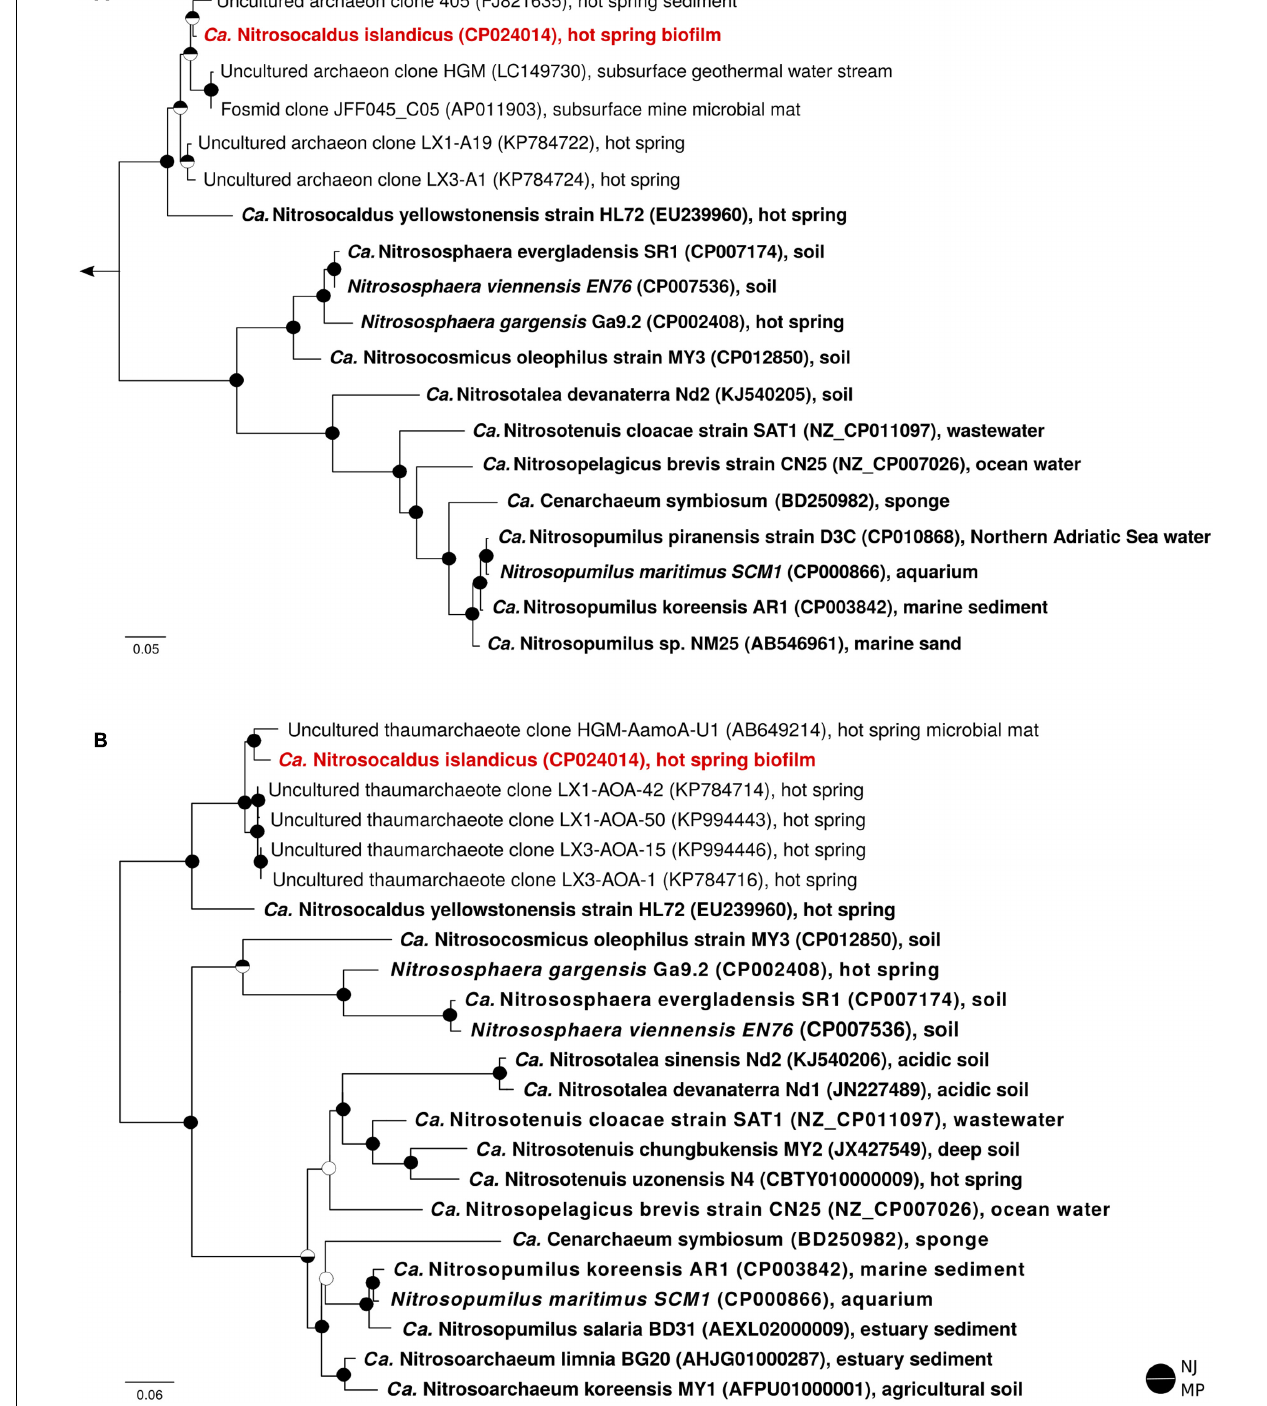
Frontiers in Microbiology |